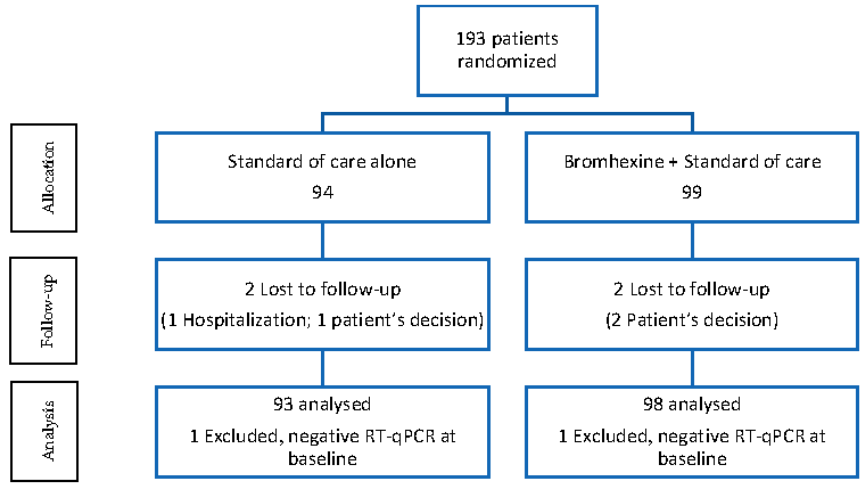
Figure 1. Flow chart of the study population. Analysis was based on the ITT dataset.